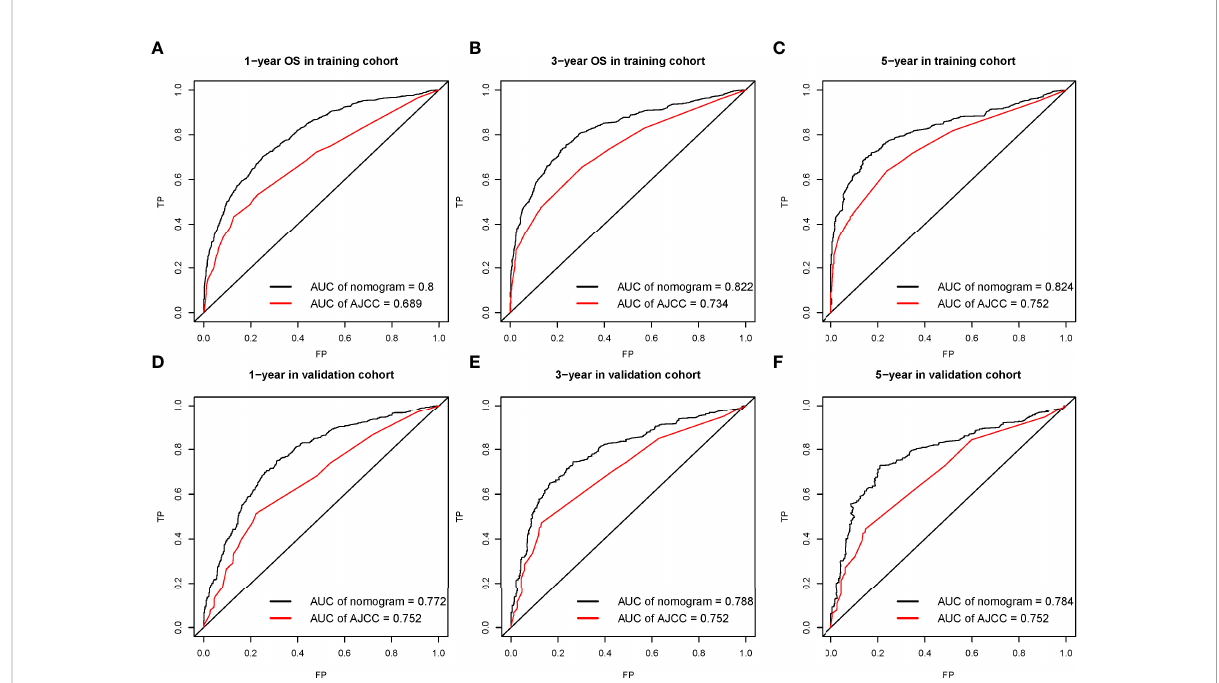
FIGURE 3 The receiver operating characteristic (ROC) curve for nomogram in the training cohort (A – C) and validation cohort (D – F) at 1-year, 3-year, and 5-year, respectively.